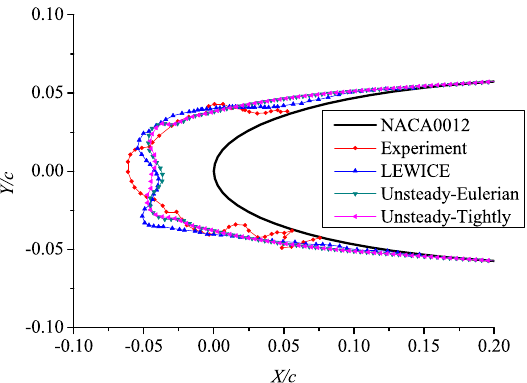
Figure 19. Comparison of ice shapes under Case 5 (Temperature = − 19.6 ◦ C).